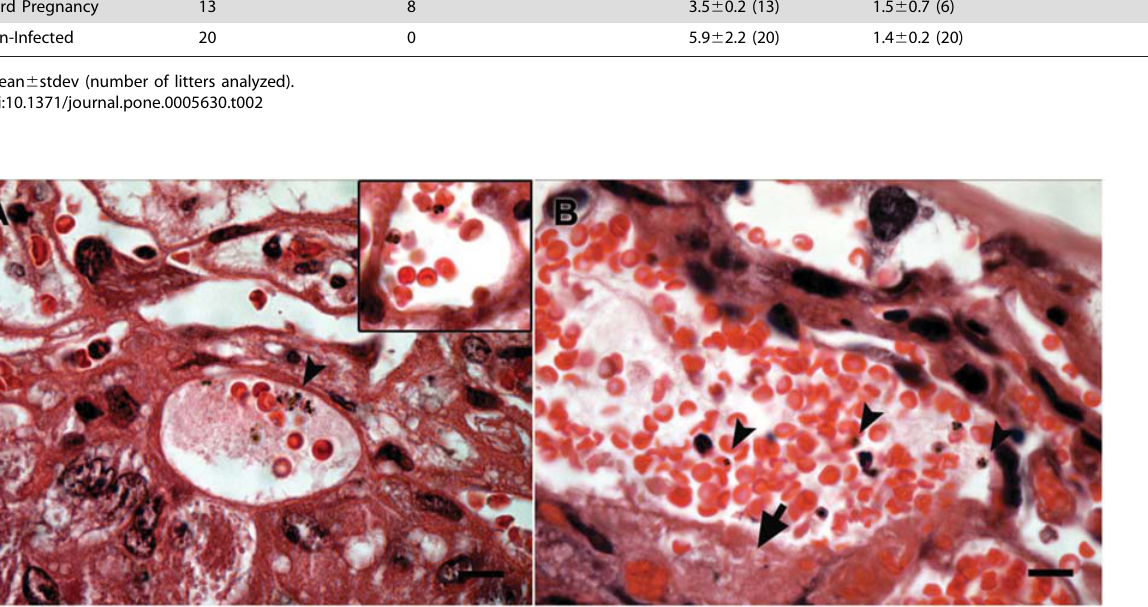
Parity Pregnant